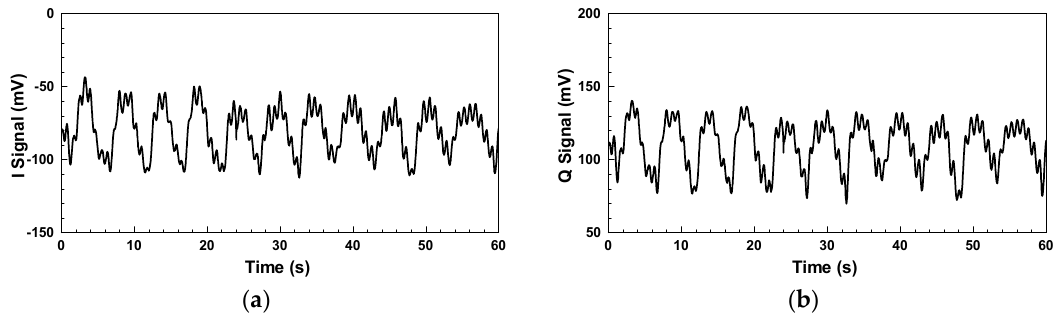
Figure 6. Baseband signals for non-contact vital sign detection using the SIL radar: ( a ) I signal; ( b ) Q signal.